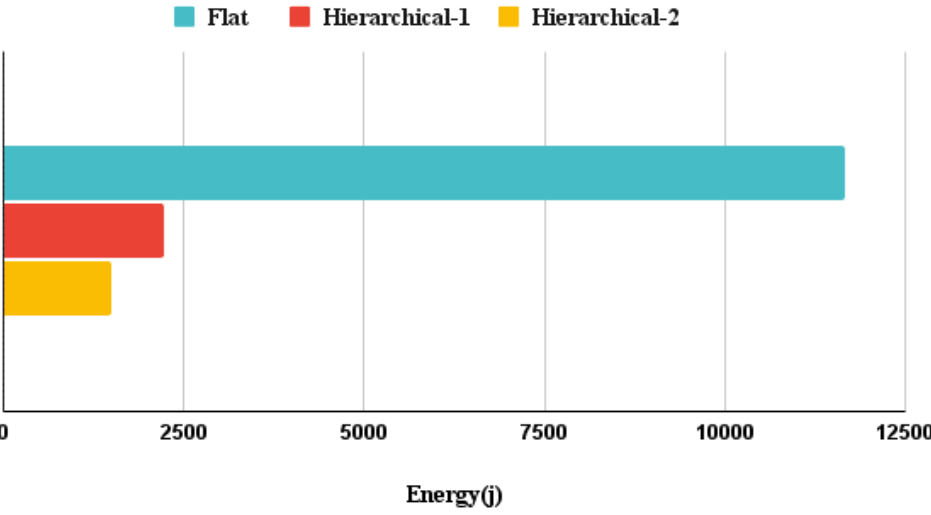
Figure 10. The total energy consumption (for all devices) for different topologies.